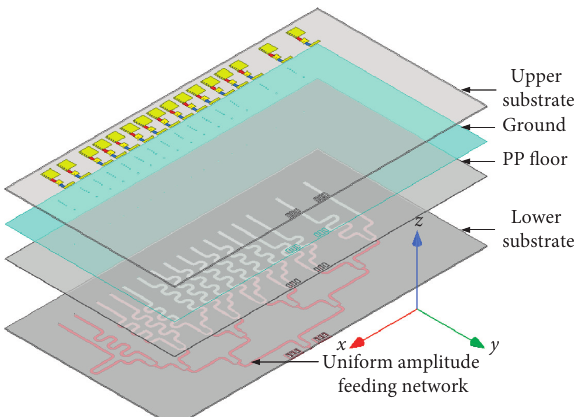
Figure 18: Structure of the FRAA prototype with uniform am- plitude feeding network.